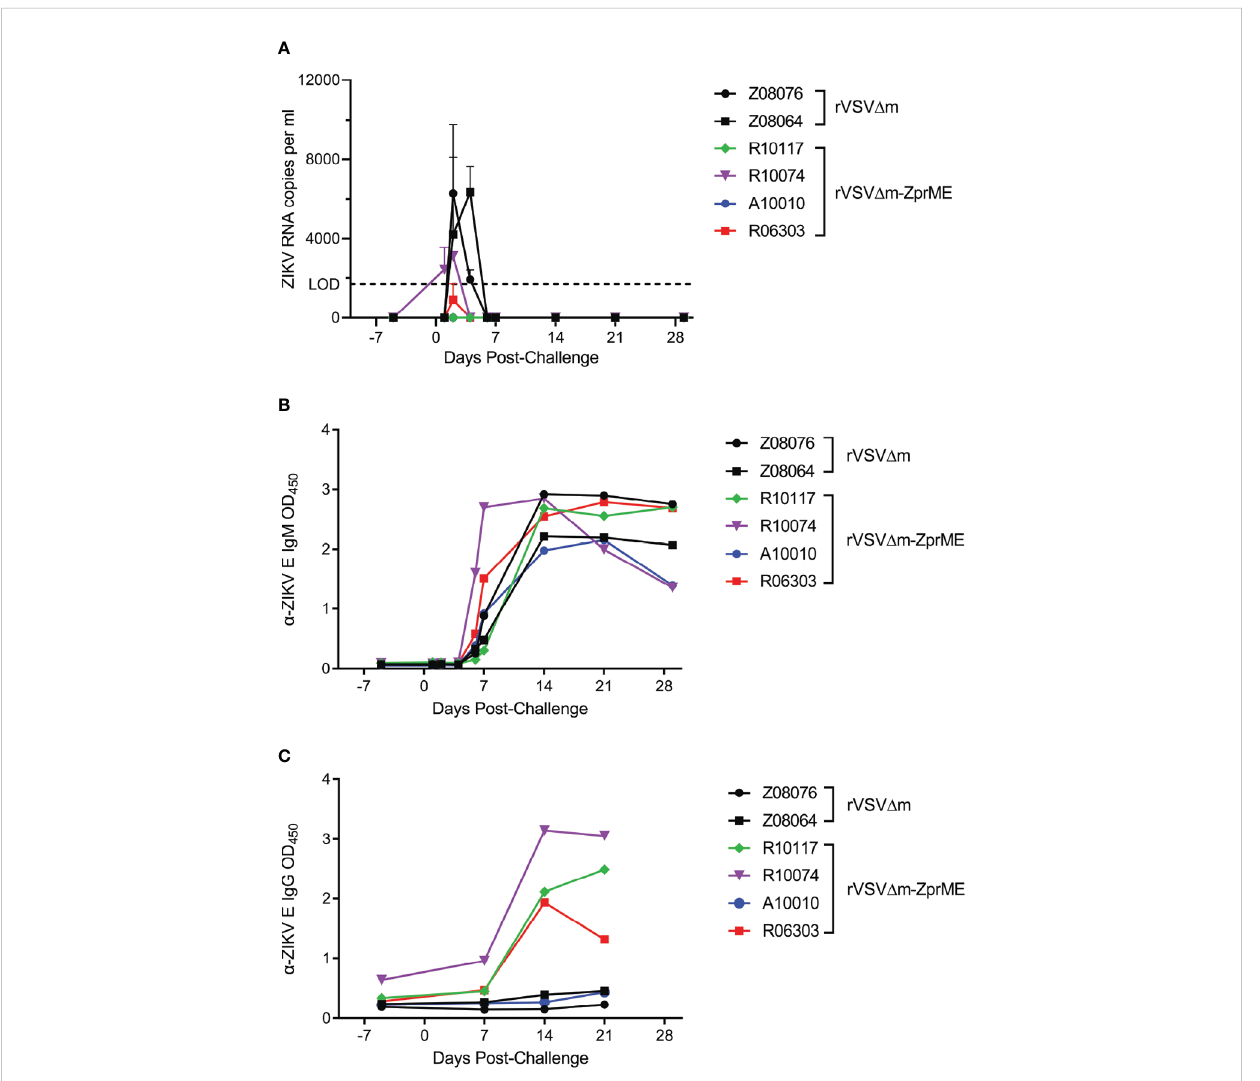
FIGURE 4 rVSV D M-ZprME ef fi cacy assessment. (A) ZIKV RNA levels in plasma were measured using a ZIKV prME-speci fi c qRT-PCR assay. The limit of detection (LOD) of the assay (1700) is marked by the dashed line. Anti ( a )-ZIKV Env-speci fi c (B) IgM and (C) IgG responses in all animals were measured by ELISA (OD450 nm). Pre-challenge and post-ZIKV challenge samples were diluted 1:100 and run for each assay. OD, Optical Density. (A – C) The data points on the plots represent individual animals for rVSV D M (black) and rVSV D M-ZprME (colored) vaccine